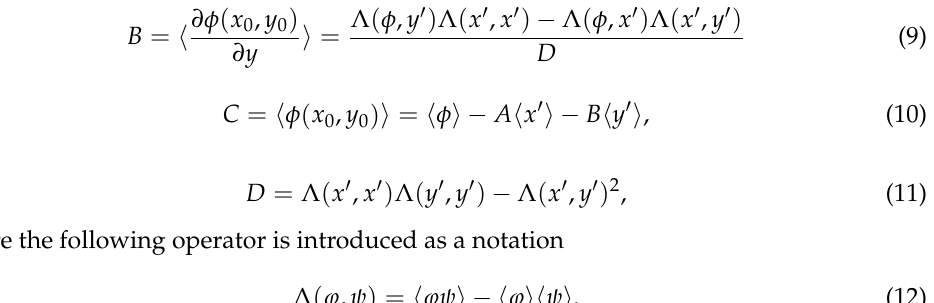
(cid:0) (cid:1) n y , − n x is the